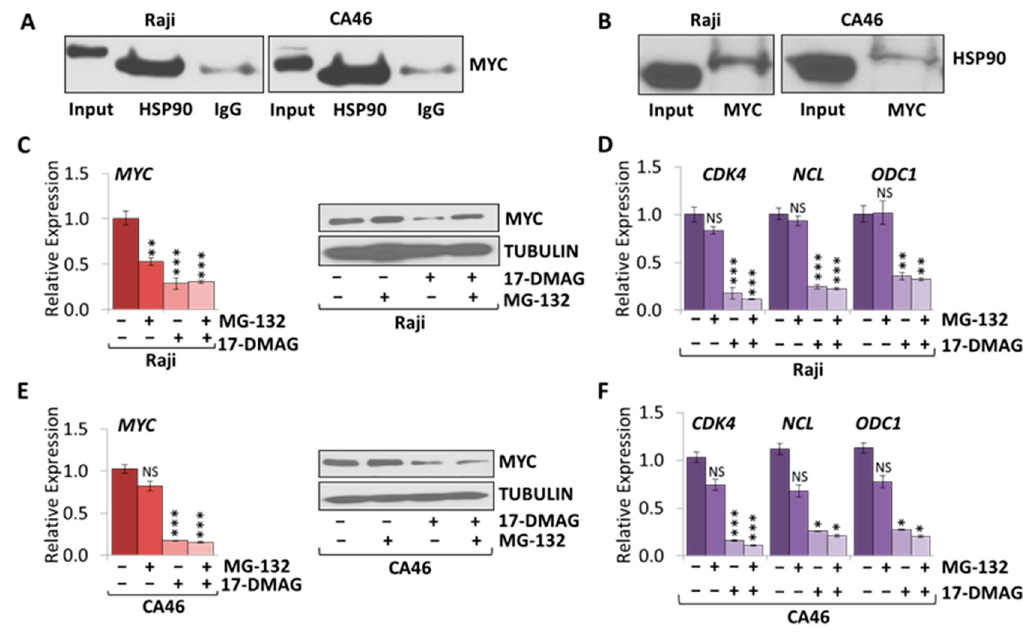
Figure 6. 17-DMAG treatment causes proteasomal degradation of MYC protein in Burkitt Lymphoma. Co-IP was performed in Burkitt lymphoma cell lines, Raji and CA46. ( A ) HSP90 was immunoprecipitated and blotted for MYC expression. ( B ) MYC was immunoprecipitated and blotted for HSP90 expression. RT-qPCR and WB of MYC expression upon 1 µ M 17-DMAG and 10 µ M MG-132 combination treatment over four hours in ( C ) Raji and ( E ) CA46 cells. RT-qPCR of canonical MYC target genes, CDK4 , NCL , and ODC1 upon three days treatment with 1 µ M 17-DMAG in ( D ) Raji and ( F ) CA46 cells. RT-qPCR was normalized to RPL13a ; Tubulin was used as a loading control for WB. Error bars represent mean ± SEM; n = 3; two-tailed Student’s t -test: NS = not significant; * p < 0.05; ** p < 0.01; *** p < 0.001.